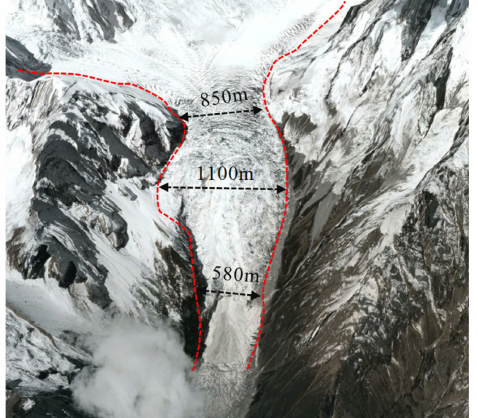
Figure 14. Three-dimensional remote sensing image of the ice cascade.